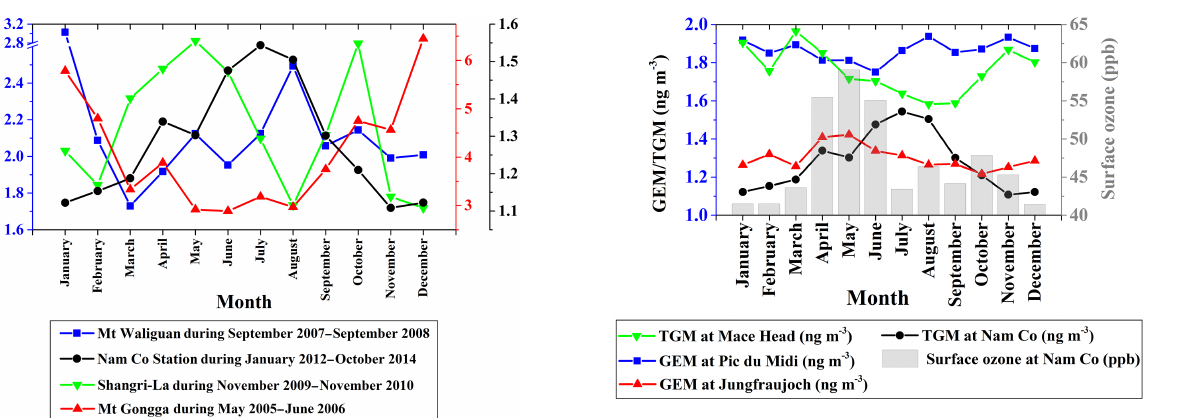
Figure 3. Variations of monthly mean TGM at four sites (Mt. Waliguan (Fu et al., 2012a), Nam Co, Mt. Gongga (Fu et al., 2008) and Shangri-La (Zhang et al., 2015)) on the Tibetan Plateau.